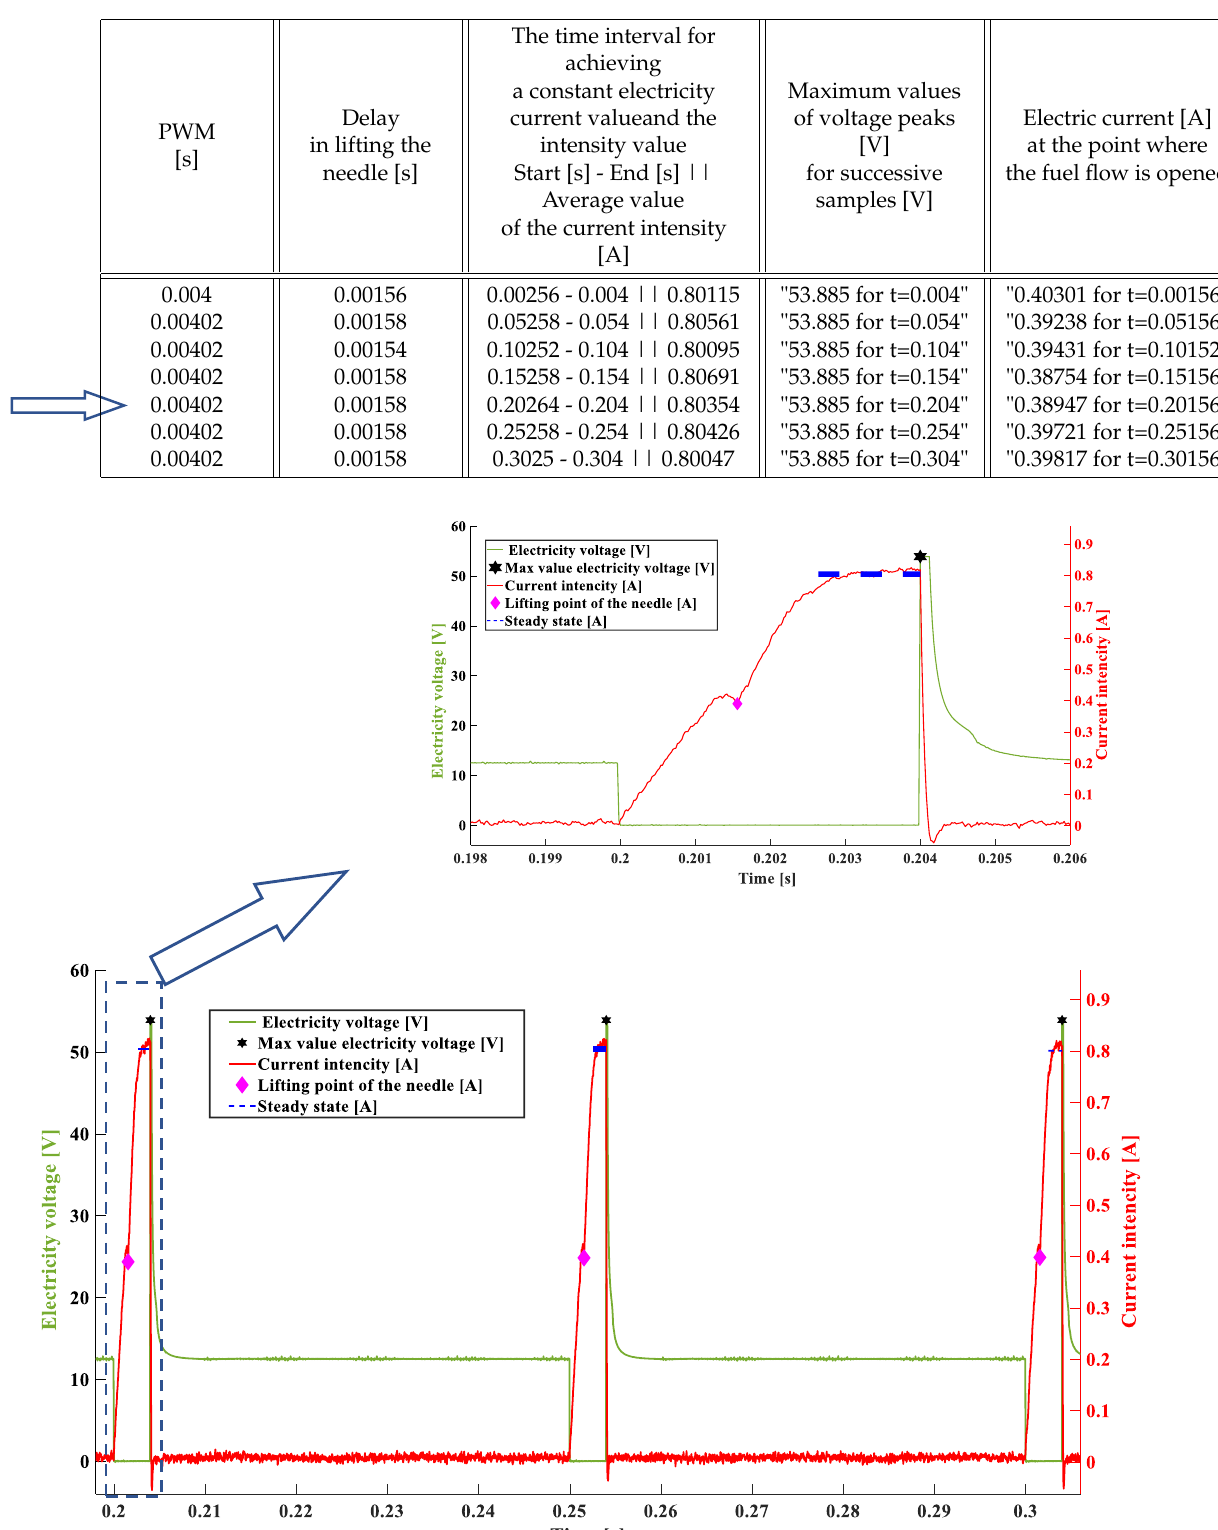
Figure 10. Characteristic values obtained in successive voltage – current waveforms representing the dosage of the fuel injector — exp. II — 4 ms, 0.4 MPa.